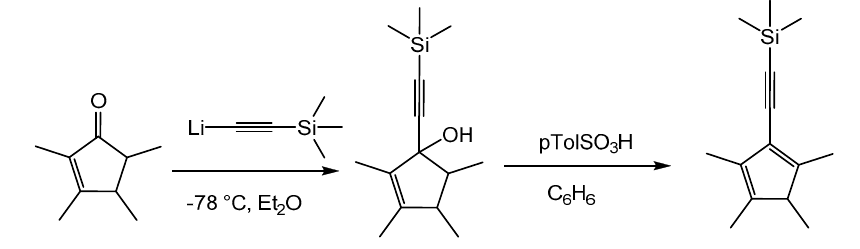
Figure 1. Molecular structure of 1 in the solid state. Hydrogen atoms are omitted for clarity. Selected